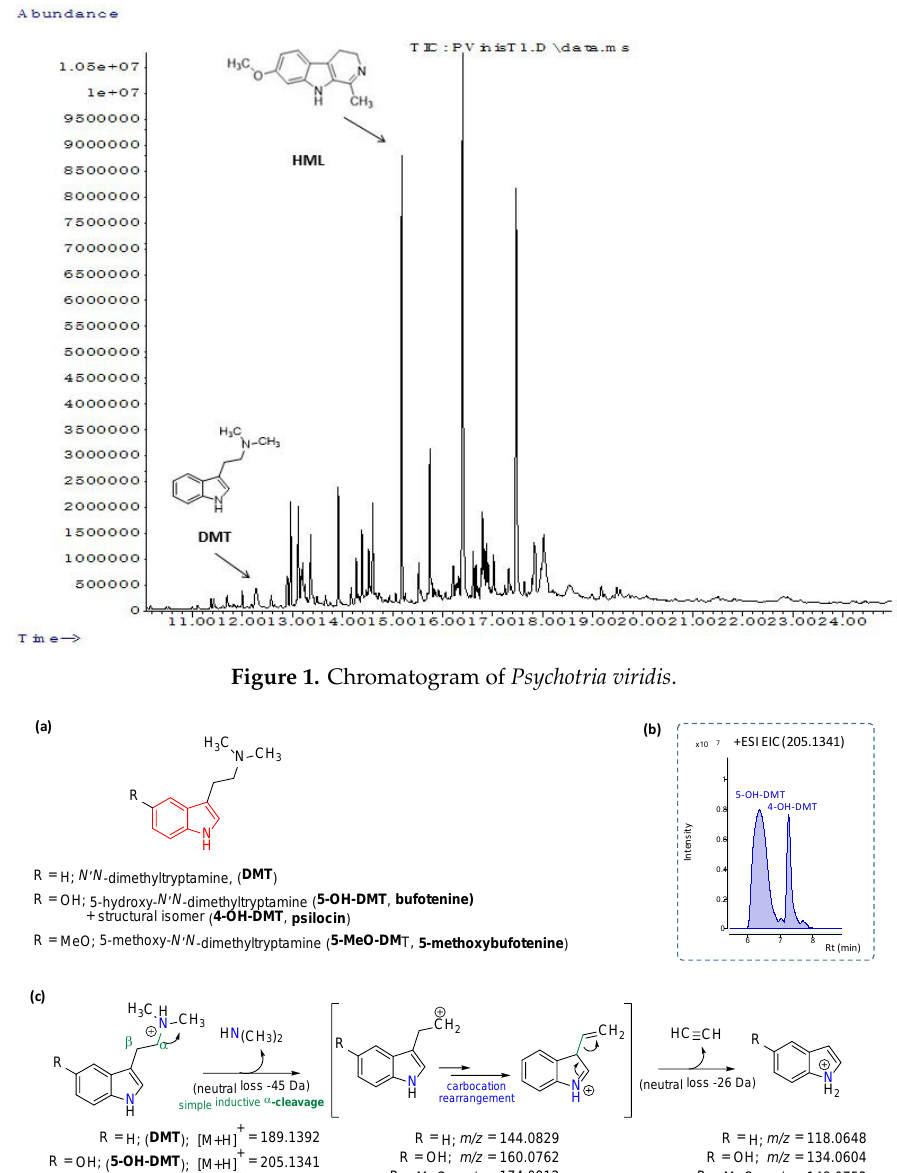
Figure 2. ( a ) Structures of the tryptamine alkaloids detected from the methanolic extracts. ( b ) Extracted ion chromatograms (EICs) at m/z 205.1341. A complete chromatographic separation was observed for bufotenine (5-HO-DMT) and its structural isomer, psilocin (4-HO-DMT). ( c ) Detail of the main fragment ions and the fragmentation pathway proposed.